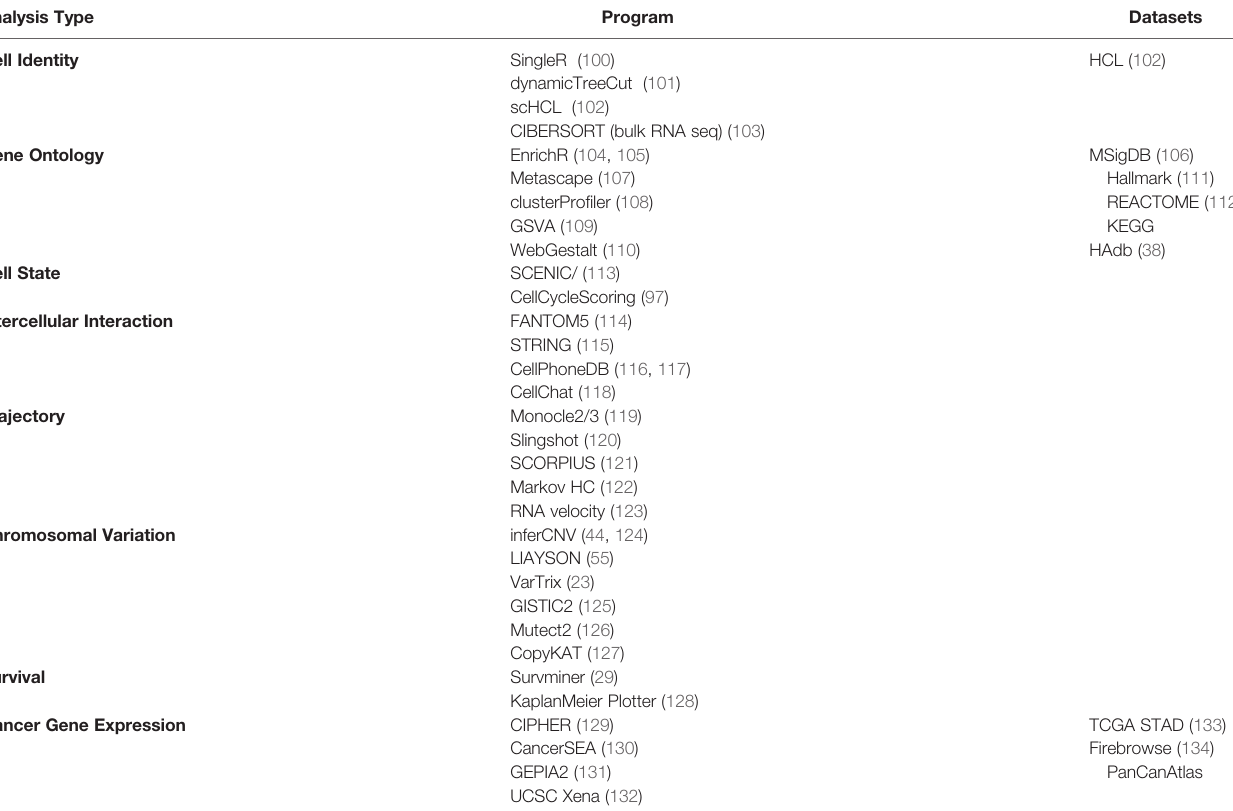
TABLE 1 | Summary of analytical tools available for gastric cancer scRNAseq